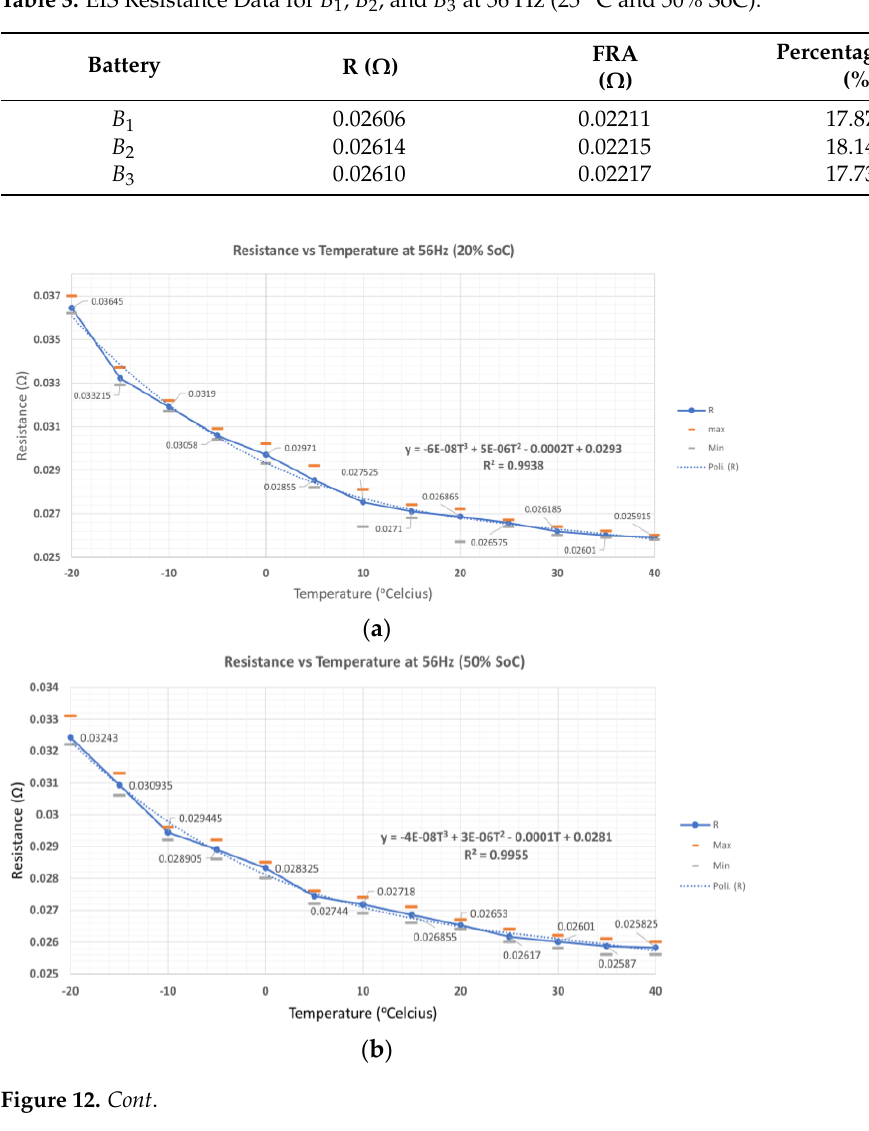
Table 3. EIS Resistance Data for B 1 , B 2 , and B 3 at 56 Hz (25 °C and 50% SoC).